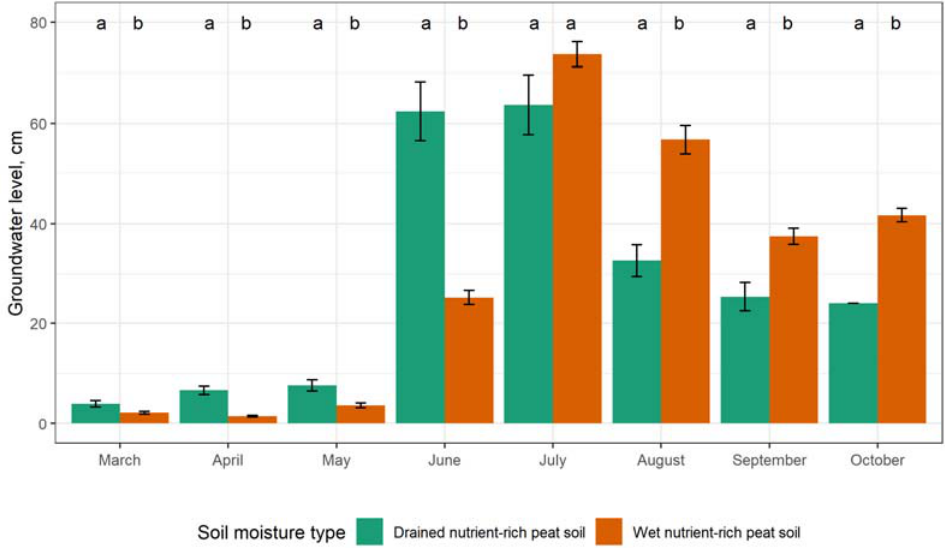
Figure 8. Monthly groundwater level from March till October in forest stands with nutrient-rich drained and wet peat soil. Different lowercase letters show statistically significant differences ( p < 0.05, two-sample t -test) between soil moisture type within the same month.